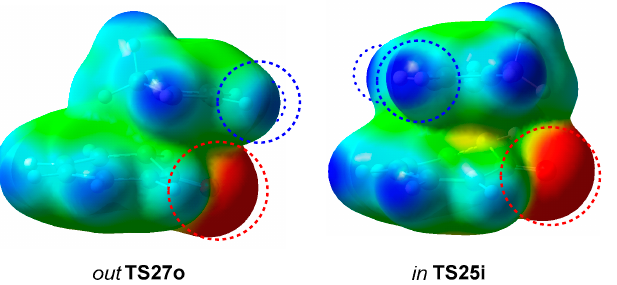
Figure 5. ω B97X-D/6-311G (d,p) Maps of the MEP for out TS27o and in TS25i . C10H–C12H hydrogens are highlighted by line-dashed blue circles, while the O8 oxygen is highlighted by a line-dashed red circle.